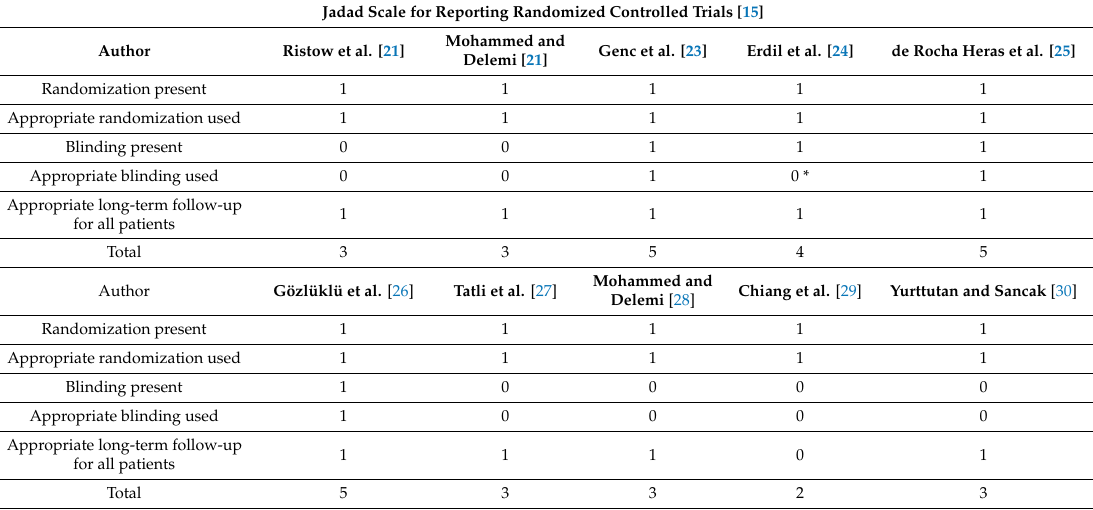
Table 2. Quality assessment according to the Jadad